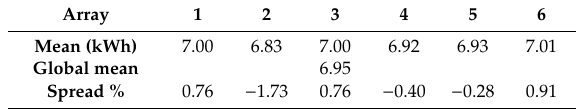
Table 1. Mean energy and spread with respect to the global mean for the quarter analysis.